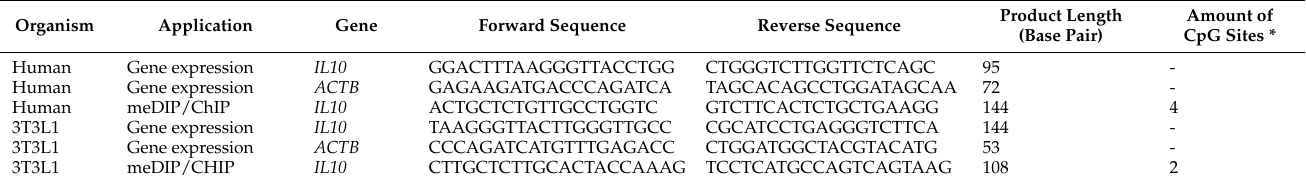
Table 1. The primer pairs used in a study for analysis of gene expression, site-specific DNA methyla- tion (meDIP) and site-specific histone modifications